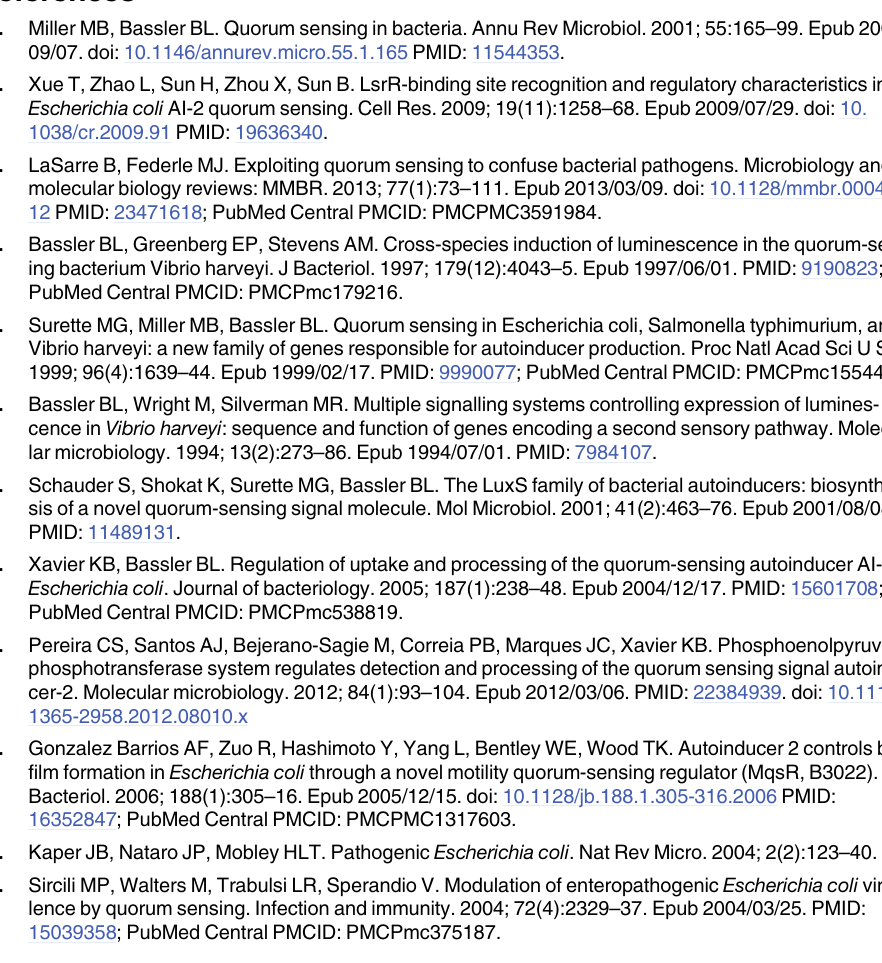
represent the amino acids in which AI-2 bind to in the binding pocket of the LsrB receptor. S2 Fig. The effect of epinephrine and norepinephrine on planktonic growth. No significant effect on planktonic growth was observed in response to epinephrine or